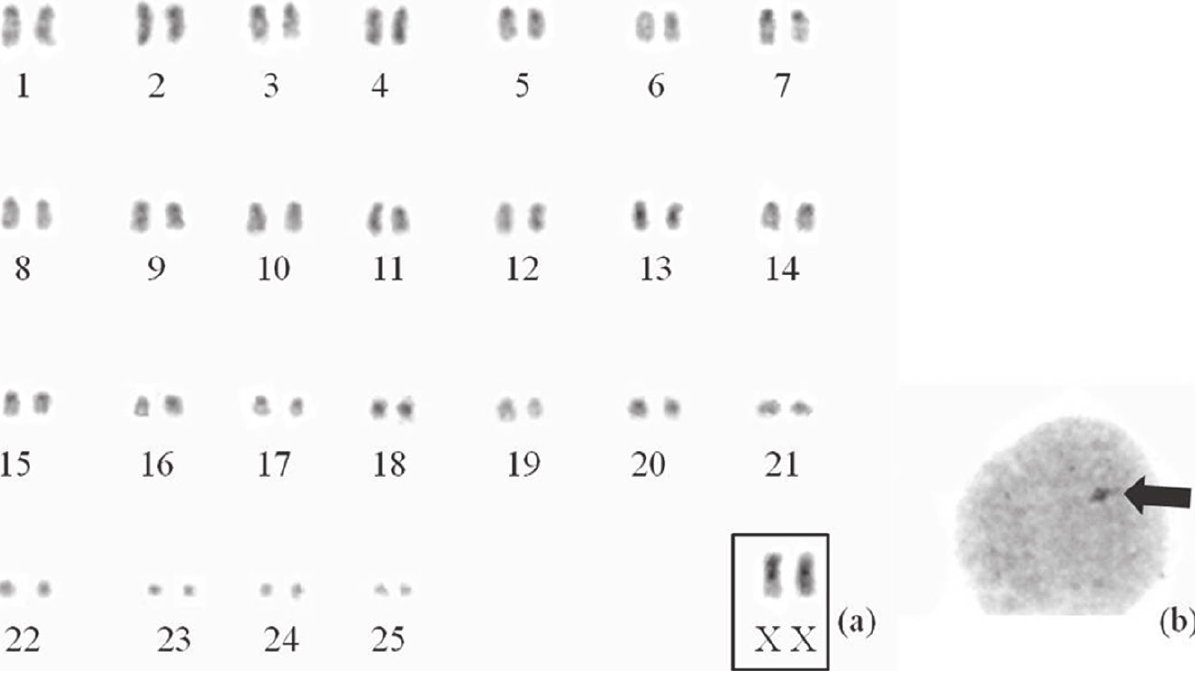
Figure 3. (a) Karyotype of Rhogeessa hussoni with C banding, showing blocks of heterochromatin in pericentromeric regions of all chromo- somes. The highlighted box shows the pair of sex chromosomes. (b) An interphase nucleus with evidence of Barr corpuscle (indicated by the